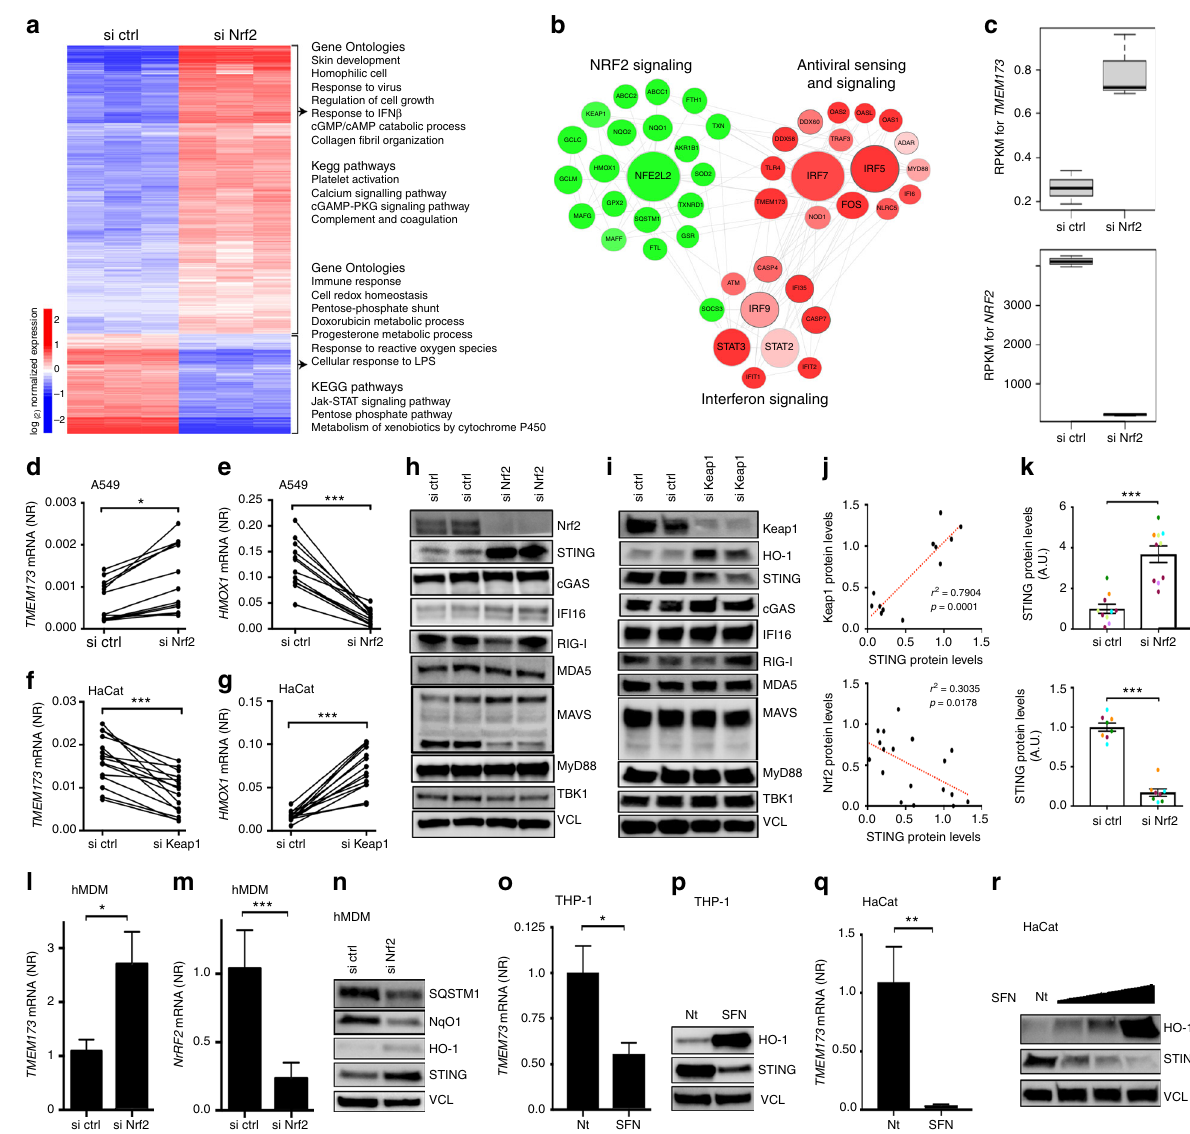
Fig. 1 Nrf2 suppresses STING expression. A549 cells were transfected with control or Nrf2 siRNA for 48 h. Samples were analysed by RNAseq and differentially expressed pathways and genes that satis fi ed p -value <0.001 and fold change cutoff >1 or < − 1 were selected. The data are from one experiment performed in triplicate. a Heat map of differentially regulated genes and a listing of representative gene ontologies and KEGG pathways associated with these genes. b Cloud analysis of differentially expressed genes. c Representation of RNA-reads for from RNAseq. Graph displays boxplots with boxes indicating mean, s.e.m. as well as min and max values. d – g Cells were transfected with control, Nrf2 or Keap1 siRNA for 48 h or 72 h, respectively. TMEM173 and HMOX-1 mRNA expression levels were monitored by qPCR. Each two connected dots represent data from one biological experiment with paired samples. h , i Antiviral sensor, adaptor or accessory molecules were examined by immunoblotting. Data are representative of two independent experiments. j Correlation between Keap1 and STING protein levels in HaCat cells and Nrf2 and STING protein levels in A549 cells using Image J quanti fi cation of western blot intensities. Correlations were calculated using a Spearman's test. Each dot represents a biological sample. k Quanti fi cation of STING staining intensities in multiple western blots using Image J. Colorations indicate sample pairing. Graphs display mean and s.e.m. l – n TMEM173 and NRF2 mRNA expression levels by qPCR ( l , m ) or western blotting ( n ) in human monocyte-derived macrophages treated with control siRNA or Nrf2 siRNA. Data represent means ± s.e.m. of experiments performed on two donors. o – r PMA-differentiated THP1 cells ( o ) or HaCat cells ( q and r ) were stimulated with L -sulforasphane (SFN) (20 μ M) for 72 h. TMEM173 mRNA and STING protein levels were determined by qPCR and immunoblotting, respectively. Data are from one representative experiment which has been repeated twice. Two-tailed Student ’ s t -test was used to determine statistical signi fi